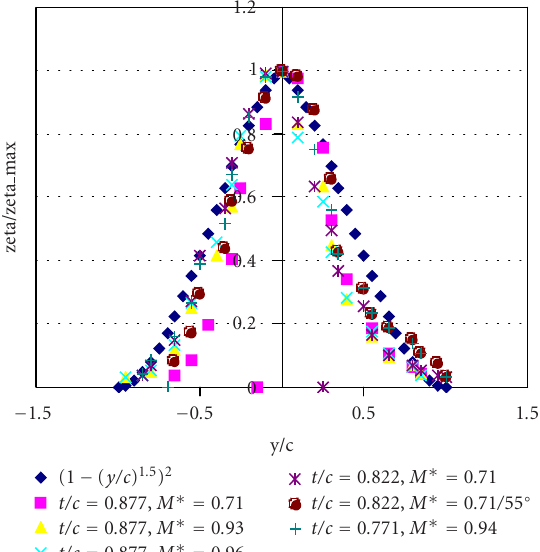
Figure 2: Shape of the wake behind a turbine blade, for Laval num- bers between 0 . 71 and 0 . 96 and pitch-to-chord ratios between 0 . 771 and 0 . 877, using identical airfoils (test data from Kurz